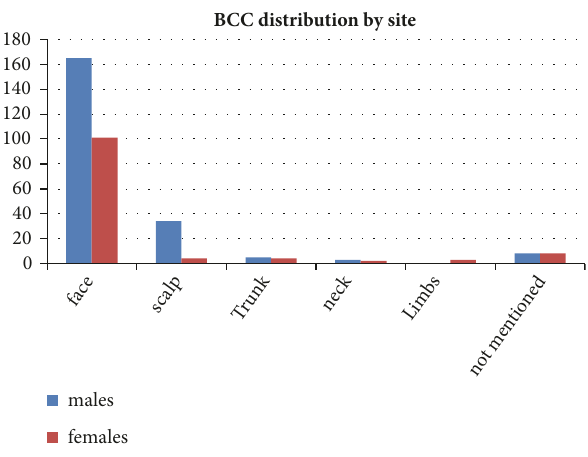
∗ Population Data for the year 2003 was absent from department of statistics and hence was not represented here.